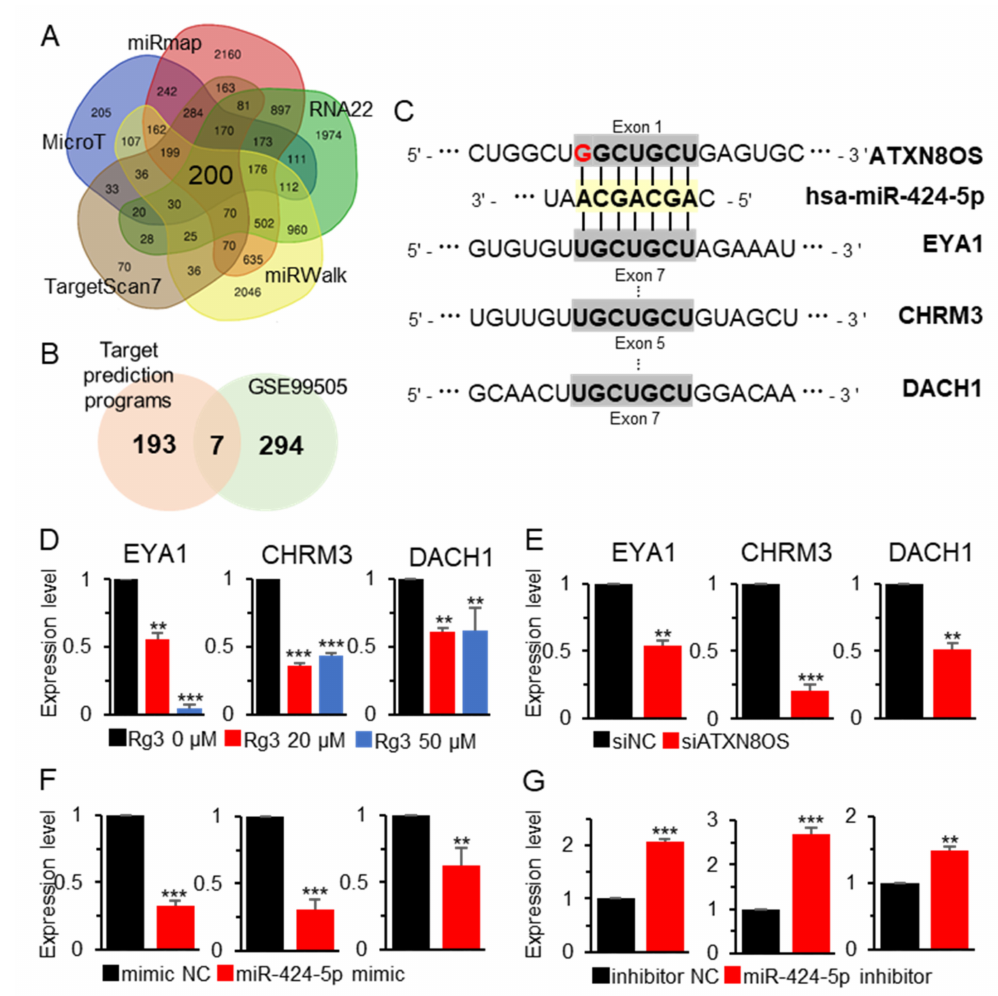
Figure 4. Regulation of miR-424-5p target genes by Rg3 and ATXN8OS. Potential miR-424-5p target genes were identified by analyzing five public databases (miRmap, miRWalk, TargetScan, MicroT, and RNA22) ( A ), after which they were compared with the methylation-array data of the Rg3-treated MCF-7 cells (GSE99505) ( B ). ( C ) Potential binding sequence of the target genes on miR-424-5p. The seed sequence is denoted in bold. ( D – G ) Effect of Rg3, ATXN8OS, and miR-424-5p on miR-424-5p target-gene expression. Gene expression was examined by qRT-PCR for samples treated with Rg3 ( D ), ATXN8OS-specific siRNA (40 µ M) ( E ), miR-424-5p mimic (40 µ M) ( F ), and a miR-424-5p inhibitor (20 µ M) ( G ). Testing was done using siNC, control siRNA (40 µ M); mimic NC, negative control mimic for miR-424-5p (40 µ M); and inhibitor NC, negative control inhibitor for miR-424-5p (20 µ M). All experiments were performed in triplicate, and the results are presented as the mean ± SE. ** p < 0.01, *** p <